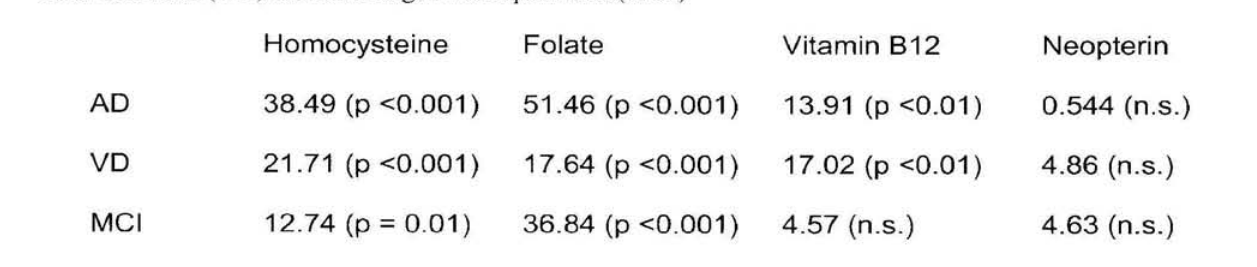
Table 1: Statistical results (H and p-values; Kruskal Wallis test) of comparisons between concentrations meas- ured at baseline and during supplementation with B-vitamins in patients with Alzheimer's dementia (AD), vas- cular dementia (VD) and mild cognitive impairment